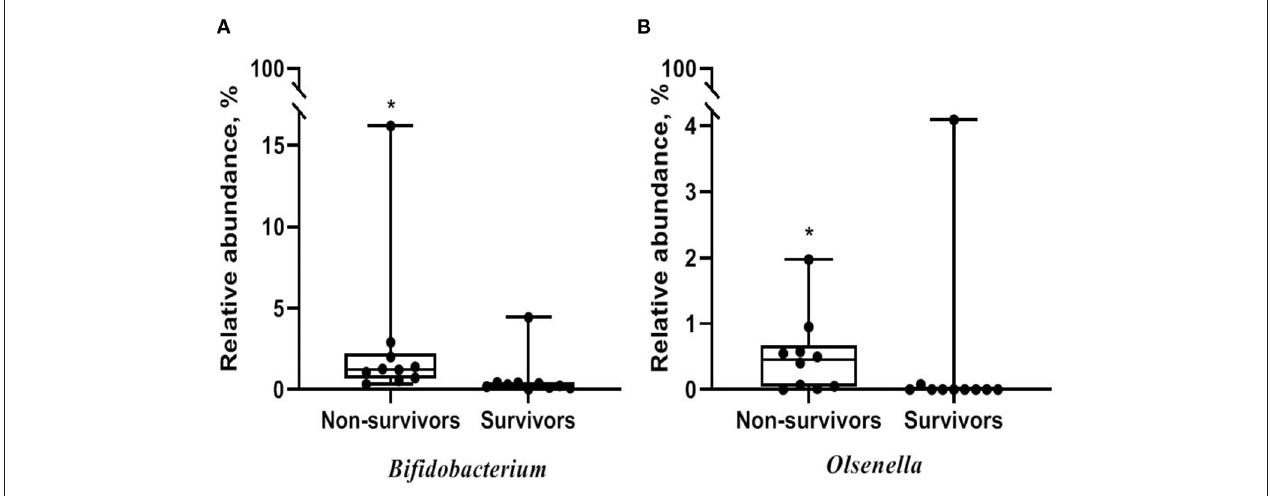
FIGURE 4 | Comparison of relative abundance of microbes between non-survivors and survivors of IPF. (A) Genus Bifidobacterium (B) genus Olsenella . The box plot represents minimum, first quartile, median, third quartile, and maximum relative abundance. IPF, idiopathic pulmonary fibrosis. * p < 0.05.